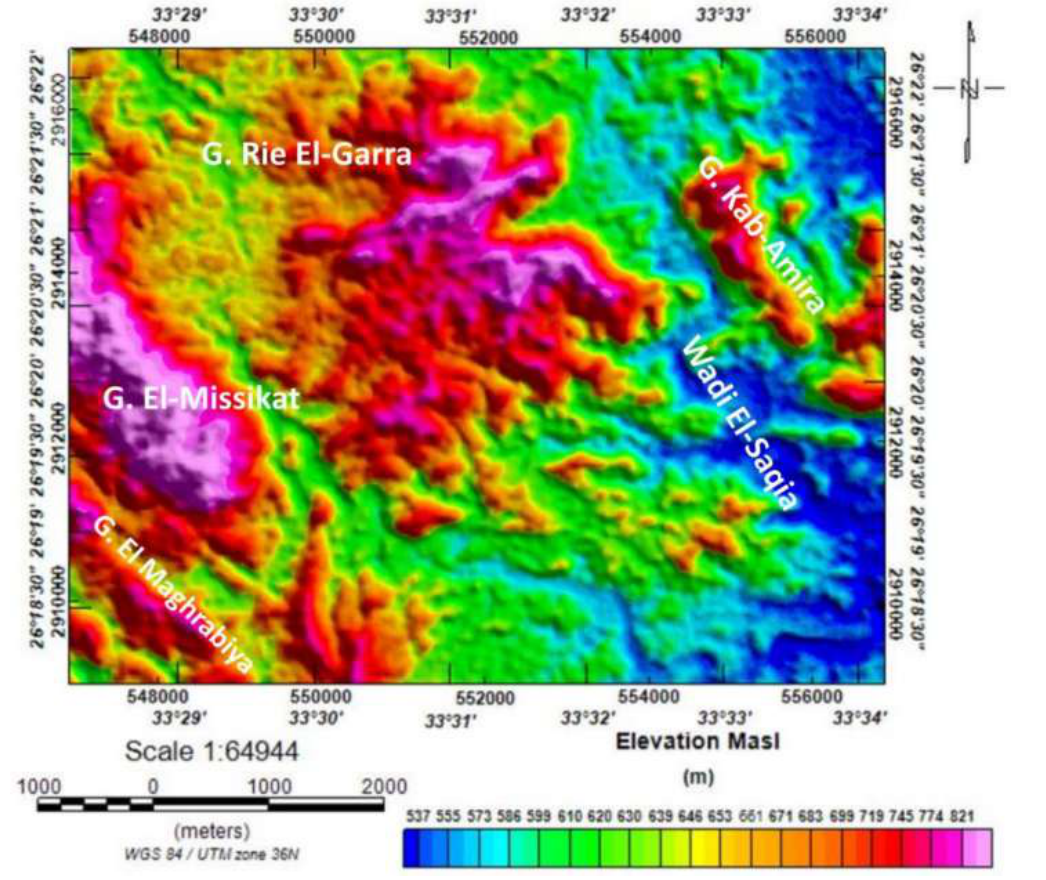
Figure 2. A shaded relief map of a digital elevation model (DEM) of the studied area, illustrating the topographic